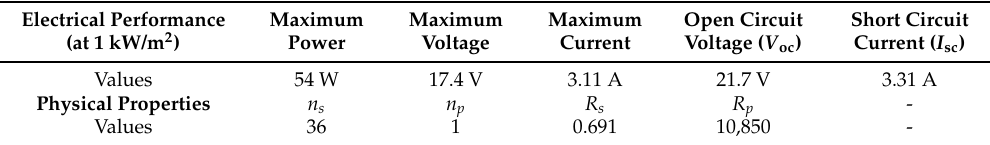
Table 1. Photovoltaic module parameter specifications